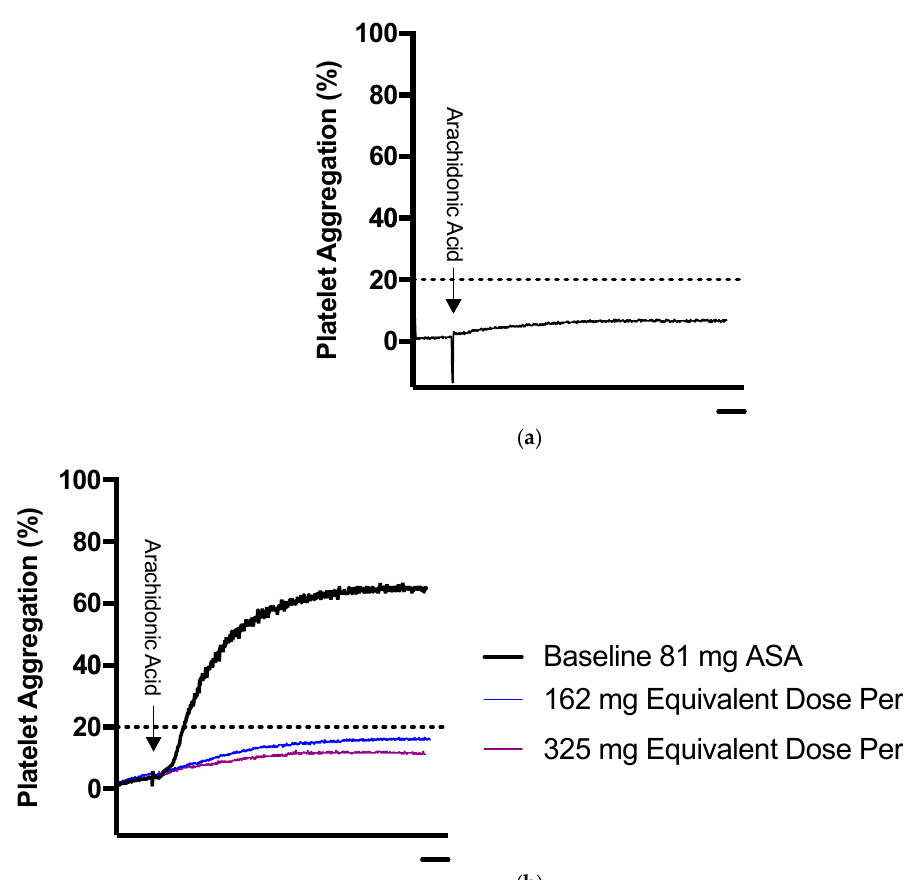
Figure 7. Sample representation of platelet aggregation results for ASA dose personalization using LTA. ( a ) Representative platelet aggregation curve of a patient sensitive to 81 mg ASA. ( b ) Representative platelet aggregation curve for patient non-sensitive to 81 mg ASA undergoing dose personalization. The blue line represents maximum platelet aggregation in platelet rich plasma spiked ex vivo with 162 mg equivalent ASA, and the purple line represents platelet rich plasma spiked ex vivo with 325 mg equivalent ASA. The dotted line represents the ASA sensitivity cut-off. Scale bars: 1 minute.